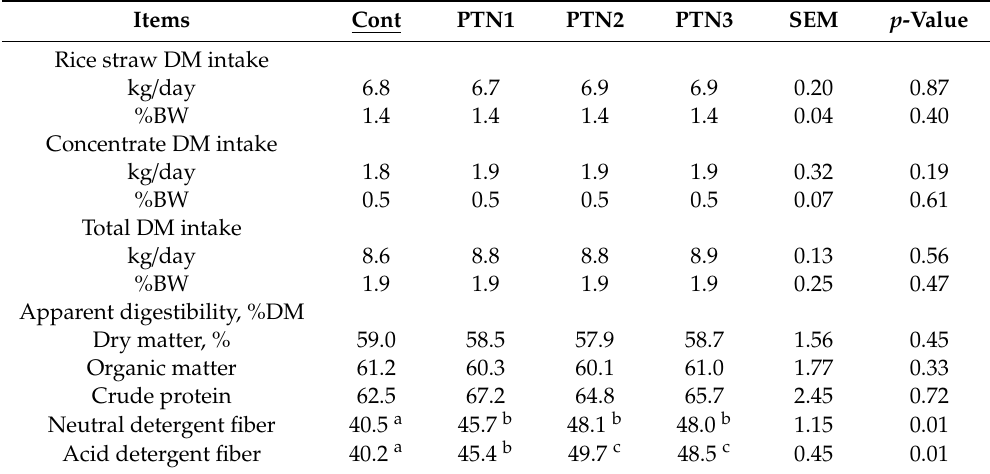
Table 2. E ff ects of some sources of phytonutrients (PTN) on voluntary feed intake and nutrient digestibility in swamp bu ff